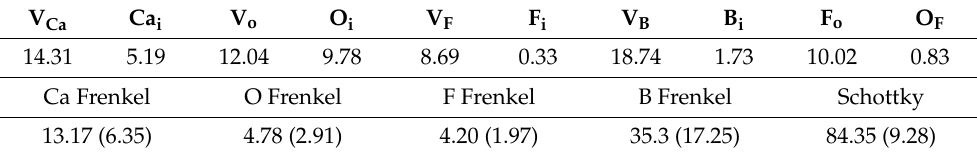
Table 3. The calculated formation energy for fifteen point defects in the CBFO crystal